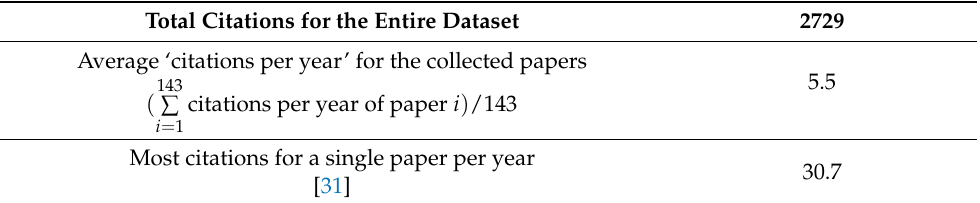
Table 2. General citation statistics for our